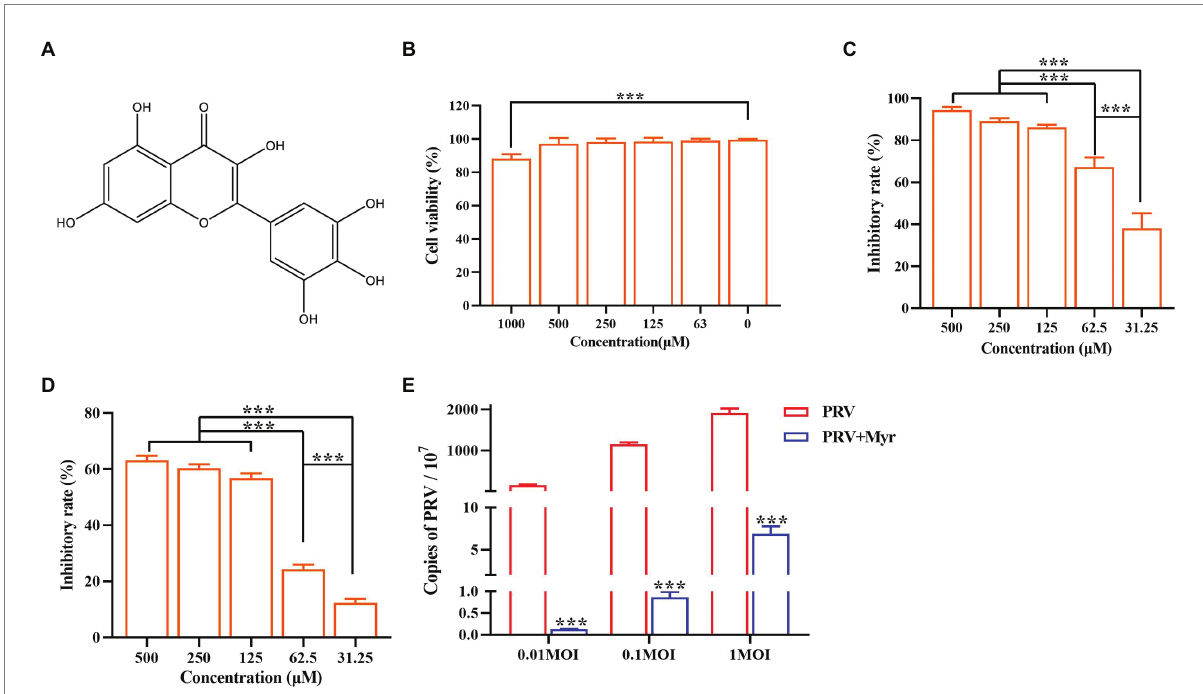
FIGURE 1 Anti-PRV activity of Myricetin. (A) The structural formula of myricetin. (B) The cell toxicity of myricetin. PK-15 cells were incubated with different concentrations of myricetin for 48 h, then the cell viability was measured by CCK-8. (C) The inhibitory rate of myricetin against PRV. PK-15 cells were infected with PRV (100TCID 50 ) and treated with myricetin at the same time. After adsorption for 1 h, the mixture was replaced with fresh medium containing myricetin to culture for 48 h. Then a CCK-8 assay was performed. (D) The inhibitory rate of myricetin on PRV replication. PK- 15 cells were infected with PRV (100TCID 50 ) and treated with myricetin after 1 h post infection. After incubation for 48 h, a CCK-8 assay was used for detection. (E) MOI assay. PK-15 cells were infected with PRV (MOI = 0.01, 0.1, and 1, respectively) in the presence of myricetin; after incubated for 1 h at 37 ° C, the mixture was replaced with fresh compound-containing medium. The DNA copy of PRV was evaluated by FQ-PCR . Values are presented as means ± SD ( n = 6). PRV, the infected group without treatment; PRV + Myr, the infected group with myricetin treatment. Symbol “***” represents p < 0.001 between the PRV group and PRV + Myr group.